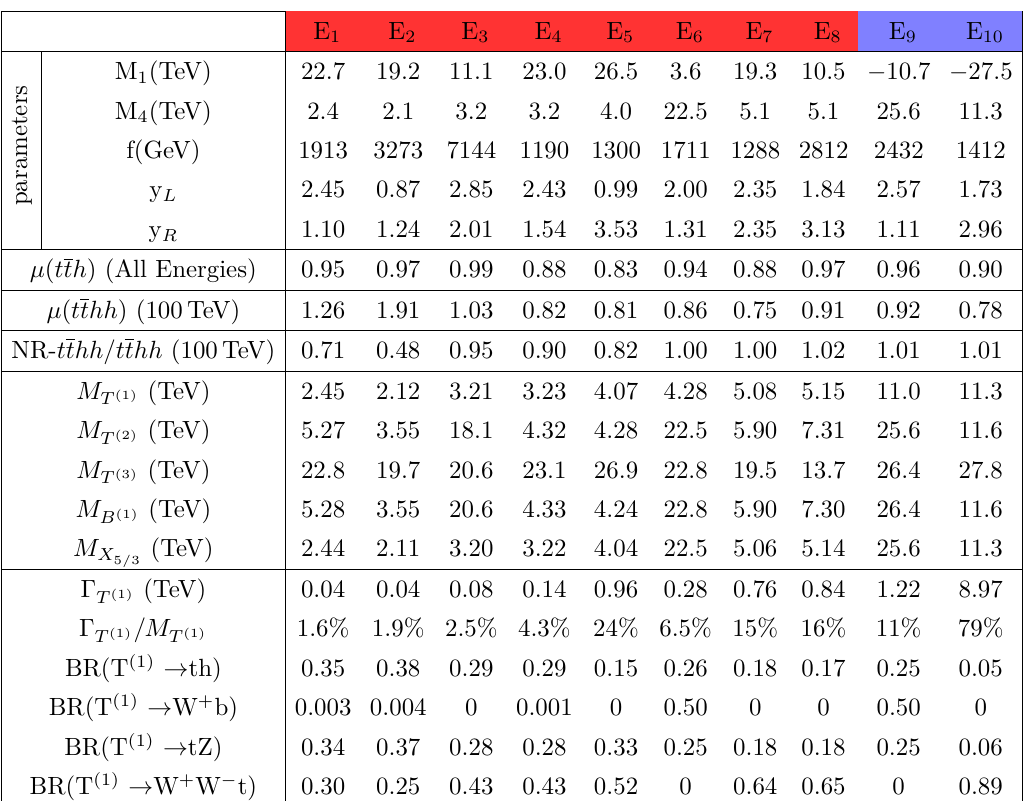
Table 7 . Benchmark points for the MCHM 5 at high scale and their main features. Red and blue column headings indicate points belonging to Region I and II